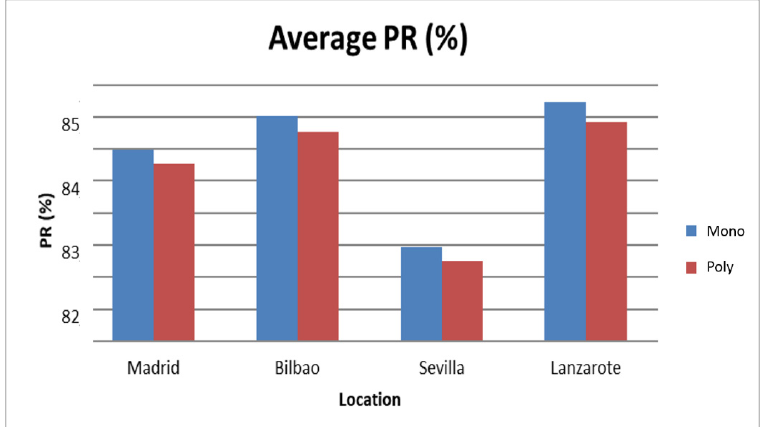
Figure 9. Average PR for each of the studied locations.